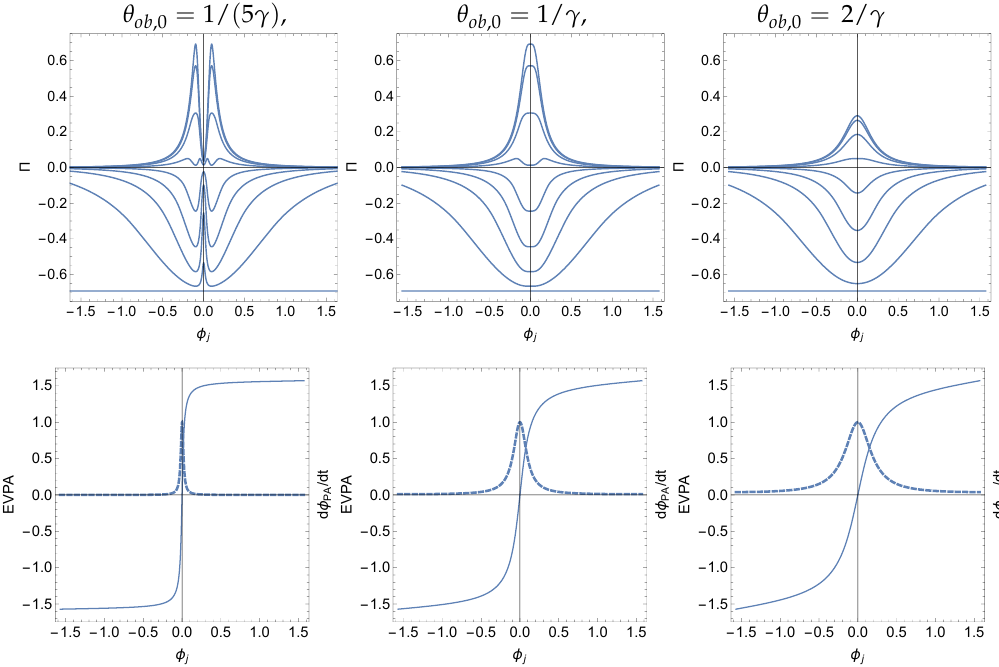
Figure 2. Polarization Π and electric vector position angle (EVPA) for a jet executing planar motion. The jet is moving with bulk Lorentz factor γ = 10 and is viewed at the minimal viewing angles of θ ob ,0 = 1/ ( 5 γ ) , 1/ γ , 2/ γ ( Left to Right columns). Top Row : Π as function of the oscillation angle for different intrinsic pitch angles (pitch angles are 0, π /16, π /8... π /2). Bottom Row : EVPA as function of the oscillation angle (solid line). Here, a larger range of angles φ j is plotted to show the full periodic behavior of EVPA. Dashed line: the rate of change of EVPA, ˙ φ PA (defined here as the projection of the jet on the plane of the sky—EVPA may differ by 90 ◦ ), normalized to the maximal